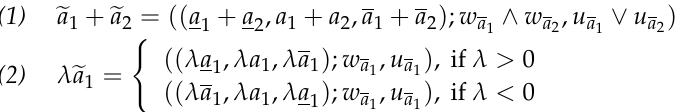
Figure 2. A TIFN (( , , ); , )